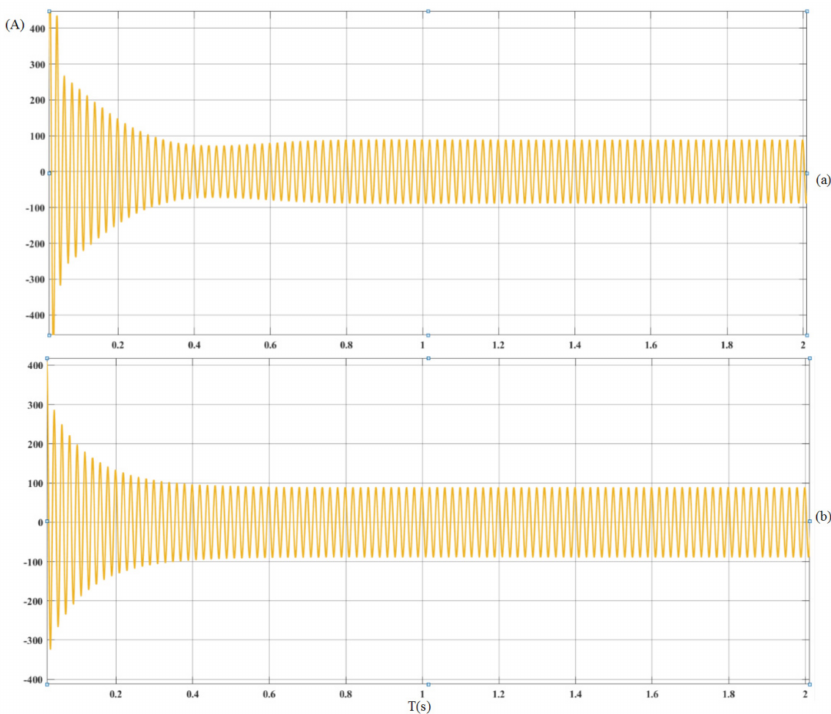
Figure 18. Startup response of AC input current waveform: ( a ) controlled by the direct power control method; ( b ) controlled by the nonlinear feed-forward PID control